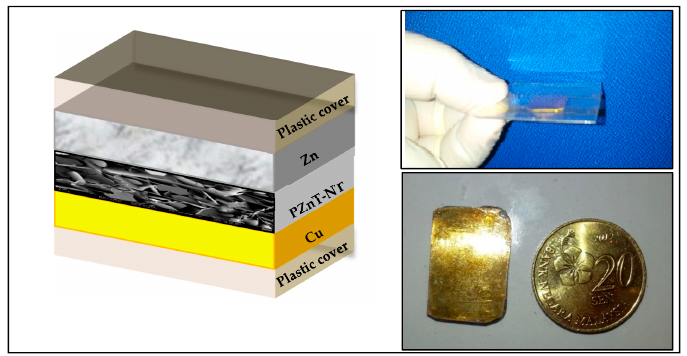
Figure 1. The piezoelectric harvester made of 0.7PbZn 0.3 Ti 0.7 O 3 -0.3Na 2 TiO 3